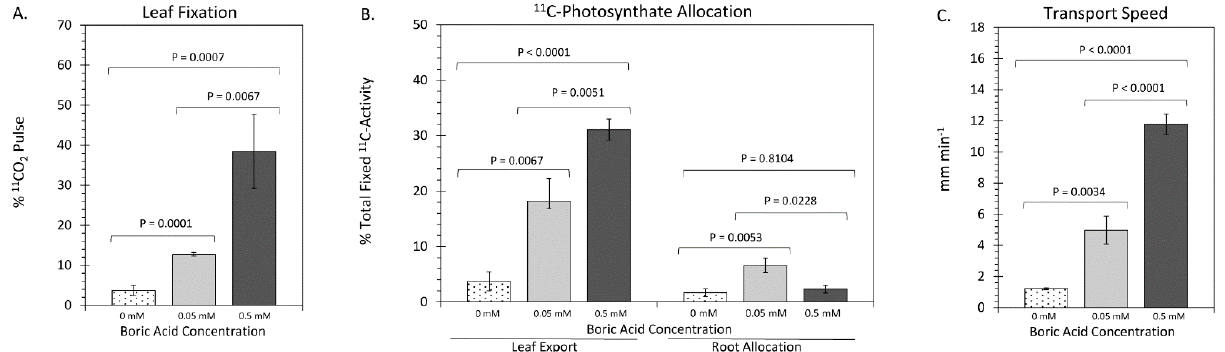
Figure 4. Plant physiological responses to growth under three regimes of boric acid (BA) treatment, including: 0 mM BA, 0.05 mM BA, and 0.5 mM BA. ( A ) depicts levels of 11 CO 2 fixation as the percent of 11 CO 2 shipped to the load leaf as a pulse normalized for differences in load leaf mass entrained within the leaf cuvette. The left side of ( B ) depicts levels of leaf export of 11 C-photosynthates presented as percent total 11 C activity fixed by the plant spanning 3 h after the radioactivity pulse was introduced to the load leaf. The right side depicts levels of 11 C-photosynthates that arrived in the root tissue over the same 3 h period. ( C ) depicts the speed of transport of 11 C-photosynthate in millimeters per minute (mm min − 1 ), as labeled substrates moved across the two defined field-of-views shown in Figure S2. All data bars represent average values ± SE from N = 8–10 replicates. Data was subjected to one-way analysis of variance with a post hoc Tukey’s HSD test to account for multiple comparisons between the different treatment groups (0 mM-to-0.05 mM BA; 0.5 mM-to-0.05 mM BA; and 0 mM-to-0.5 mM BA). Statistical significance was set at p < 0.05.